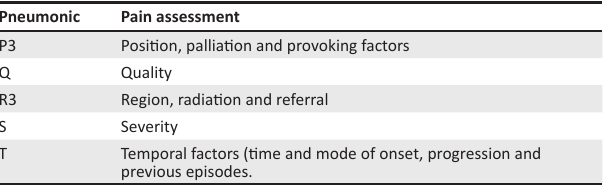
TABLE 3: Pain assessment history.